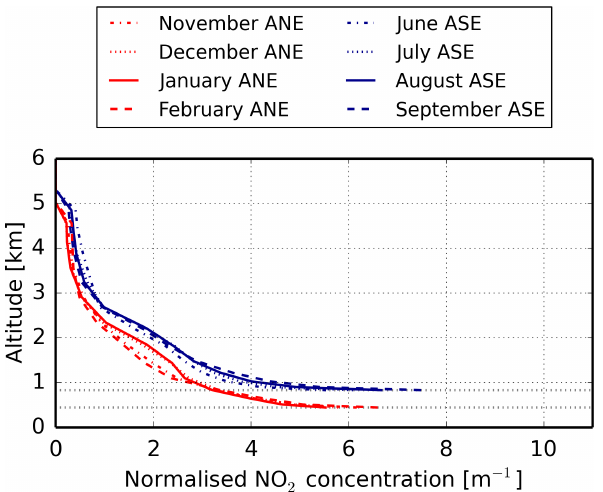
Figure A2. Average profiles of normalized NO 2 concentration for the three regions ANE and ASE for 2008, derived from the TM5-MP for 09:00 LT. The grey dashed lines indicate the surface height of the two